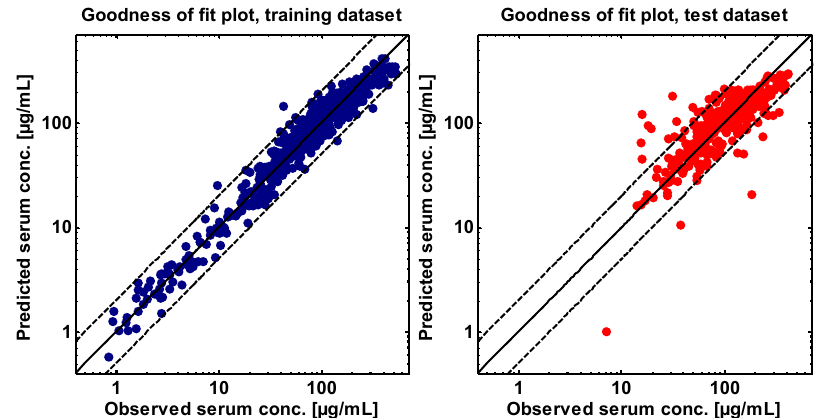
Figure 4. Asunercept goodness of fit plots illustrating the model performance for the training dataset (blue) and the test dataset (red). Shown are predicted compared to observed values of all measured asunercept serum concentrations included in this analysis. The solid lines represent the line of identity; the dashed lines indicate twofold deviation.